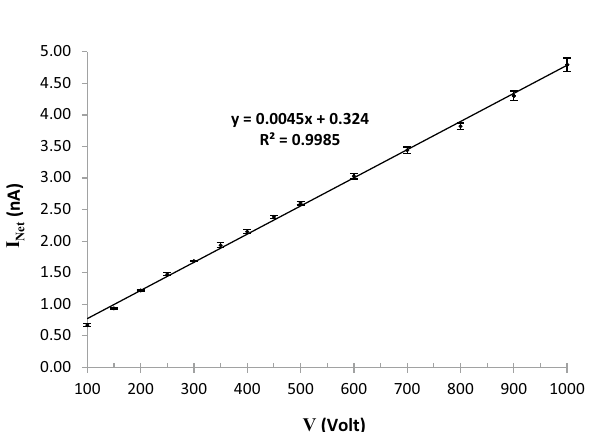
y = 0.0045x + 0.324 R² = 0.9985